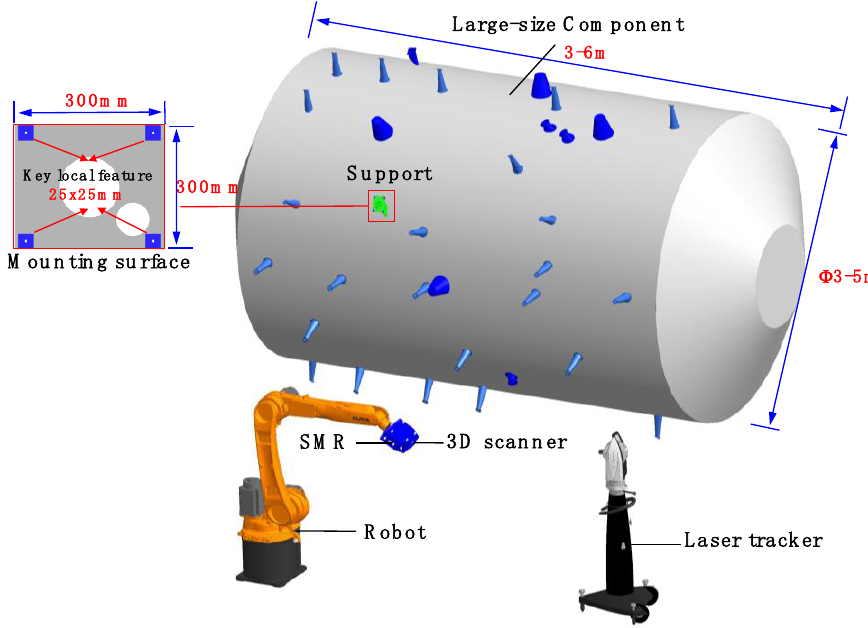
Figure 1. Hardware architecture and the combined measurement scheme.